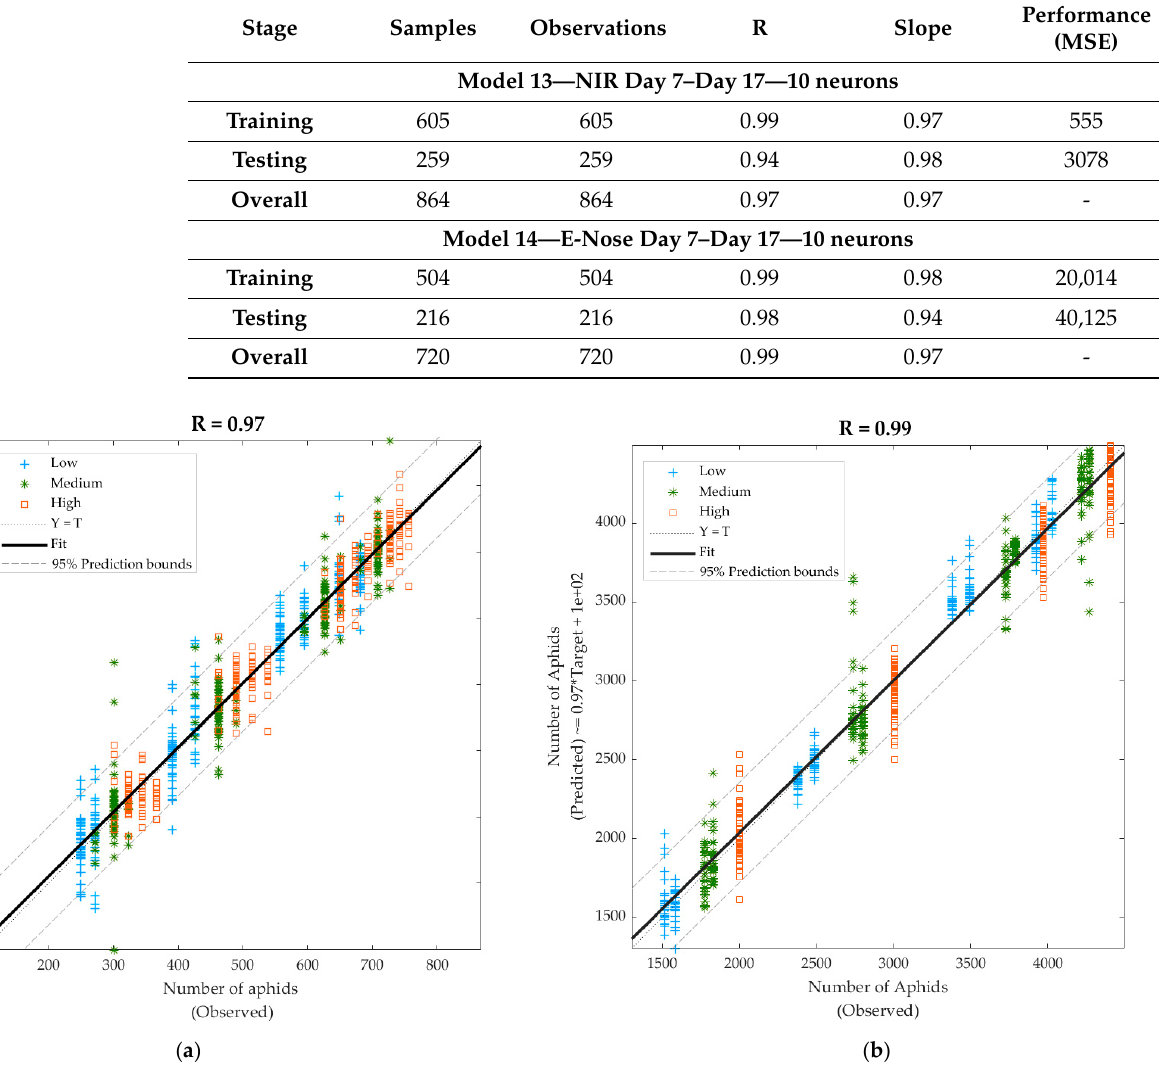
Figure 9. Overall regression models to predict the number of aphids using ( a ) the near-infrared absorbance values and ( b ) the electronic nose outputs as inputs with data from Days 7–17. Abbreviations: R: correlation coefficient; T: targets.